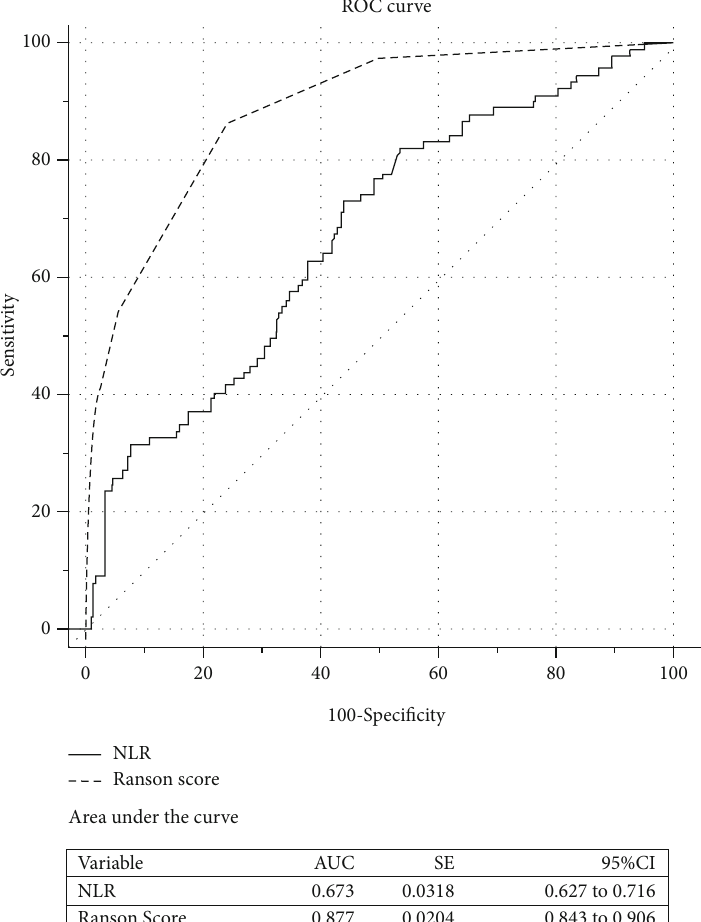
Figure 3: Area under receiver-operator curves of the NLR and Ranson ’ s score to predict the development of persistent organ failure. AUC: area under the curve; CI: con fi dence interval; NLR: neutrophil-lymphocyte ratio; ROC: receiver-operator characteristic curves; SE: standard